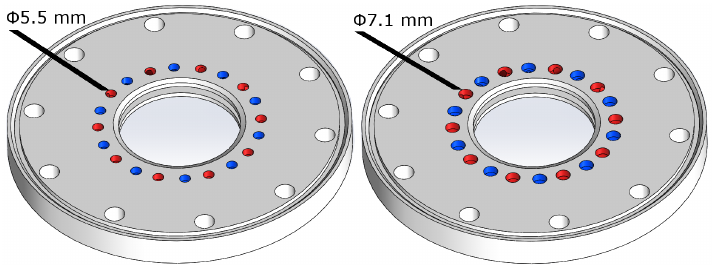
Figure 2. Minimum ( φ 5.5 mm) and maximum ( φ 7.1 mm) hole size in the valve plate ( φ 174 mm × 15 mm).